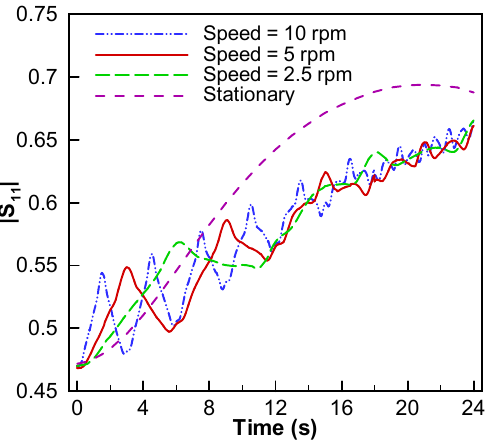
Figure 10. | S 11 | computed by the proposed method at di ff erent speeds. Figure 10. |S 11 | computed by the proposed method at different speeds.